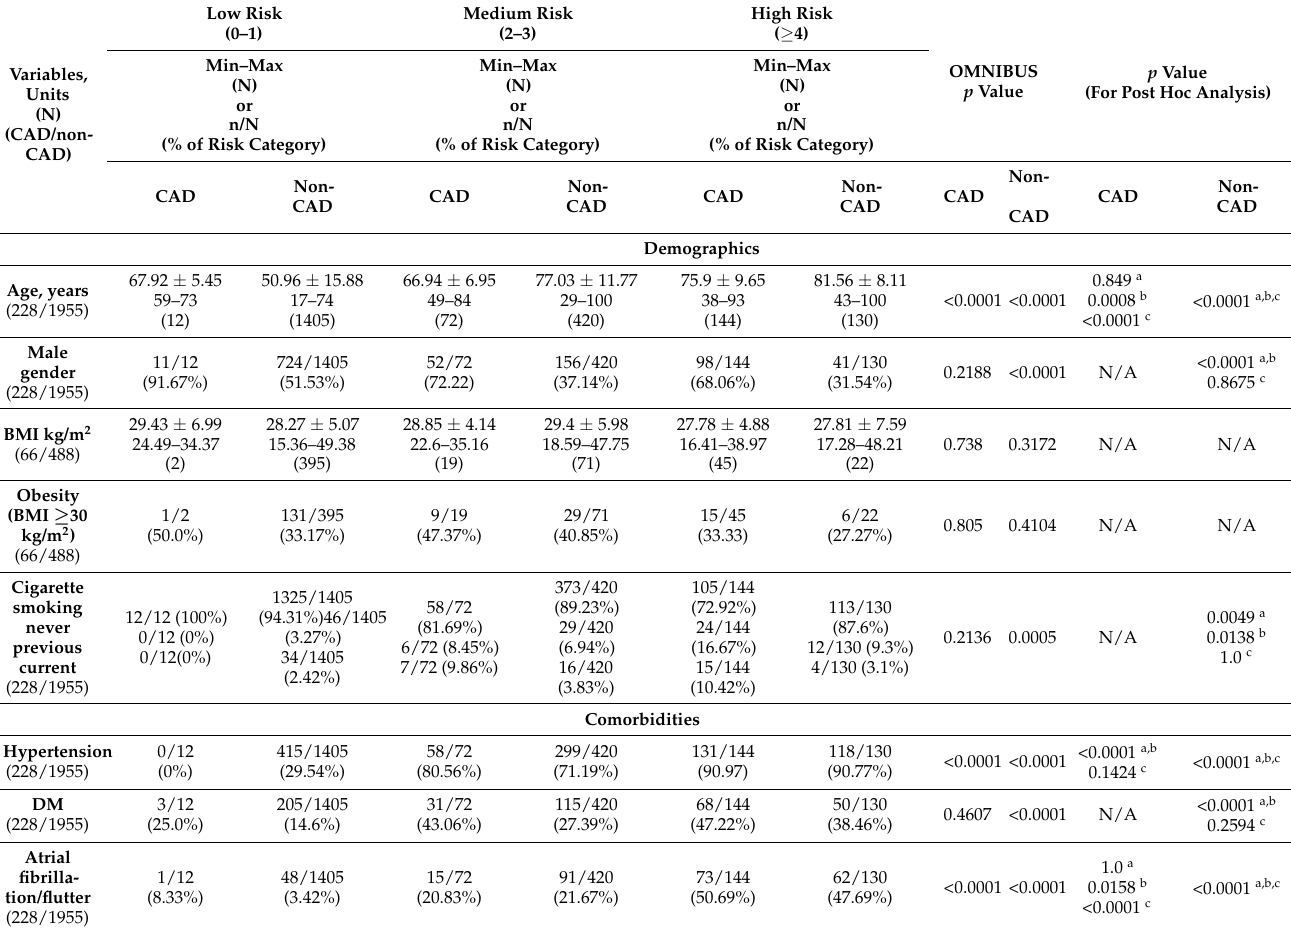
Table 1. Baseline characteristics after C 2 HEST risk stratification in the CAD and non-CAD study